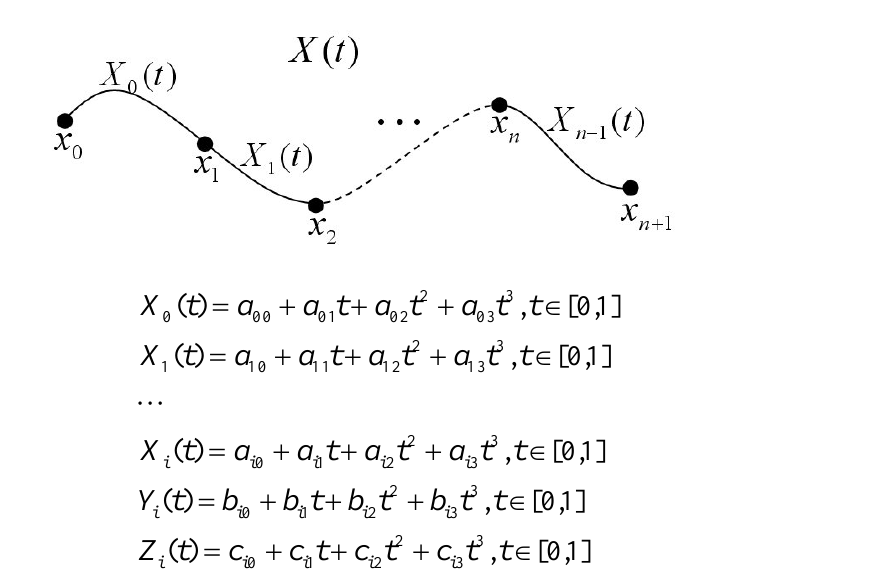
Figure 1. Natural cubic